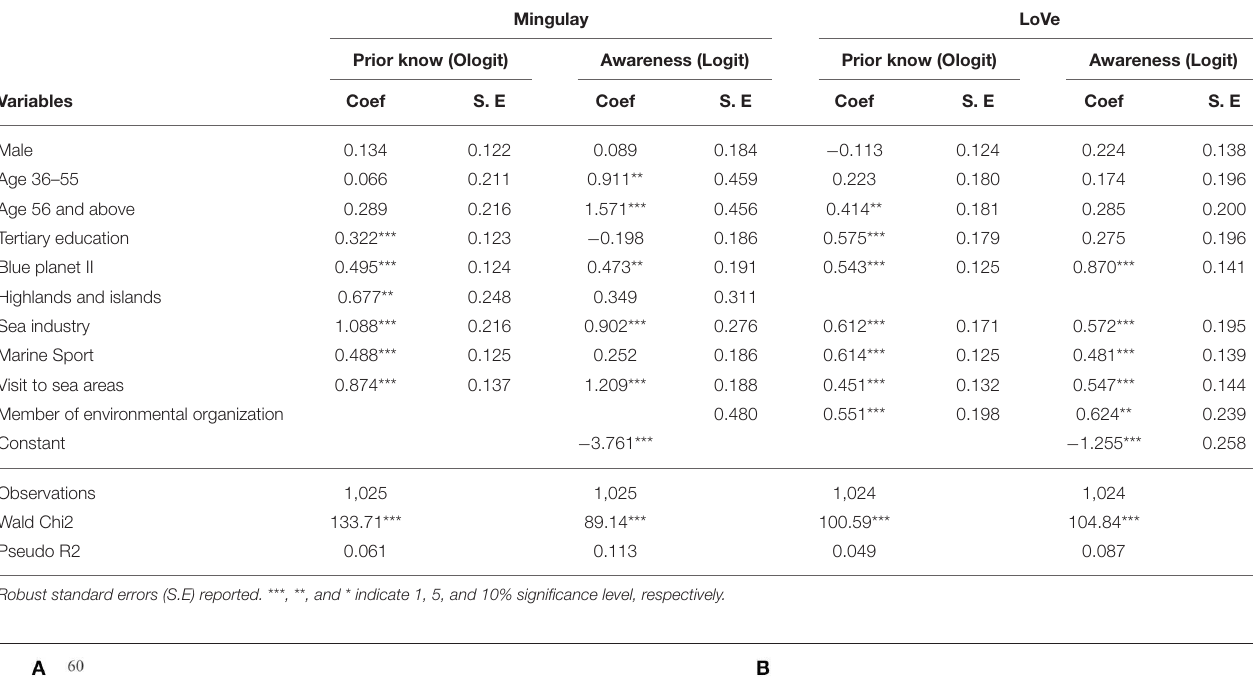
TABLE 3 | Influencers of prior knowledge and awareness.